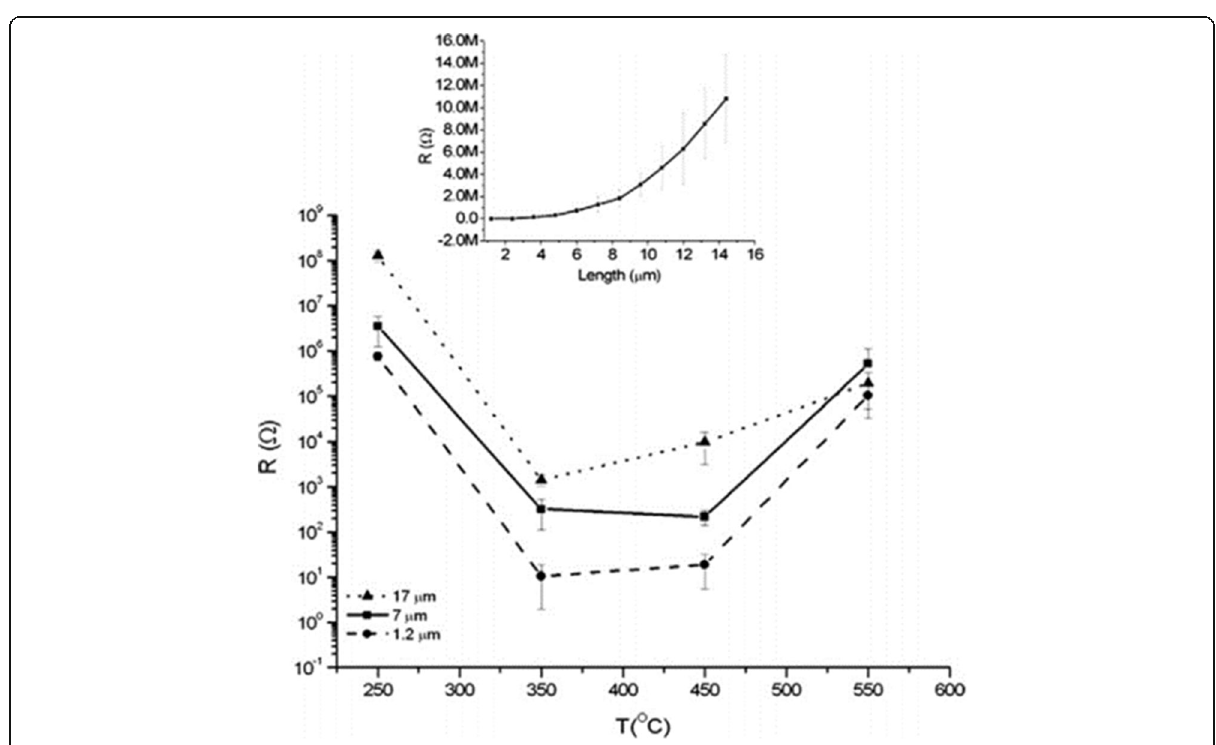
Fig. 8 Electrical resistance as a function of the annealing temperature for the different nanotube layer thicknesses. The curve shows electrical resistance measurement for different titania nanotube arrays grown in ethylene glycol based electrolyte containing HF and water at different temperature and the influence of thickness on resistance. The inset shows more details about the relationship between the thickness of the nanotube arrays annealed at 250 °C and their specific resistivity. Reproduced from ref.